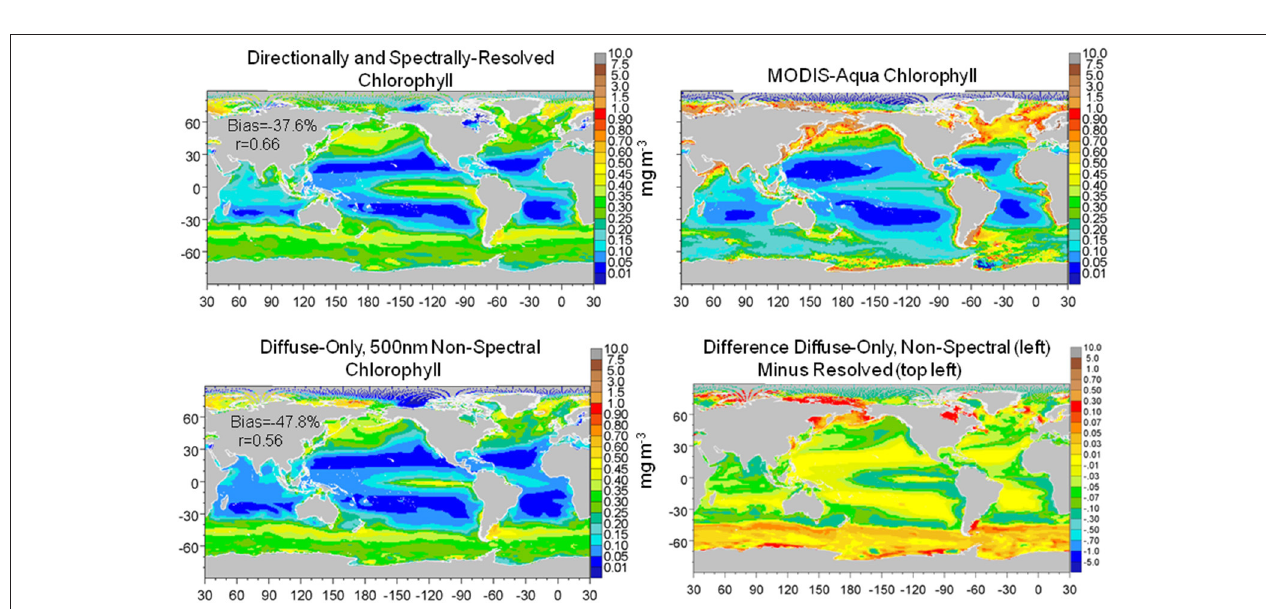
FIGURE 10 | Global distribution of chlorophyll from the directionally and spectrally-resolved model, climatological satellite data, the diffuse-only, 500 nm non-spectral simulation and the ditierence. Statistics on global distributions compared to satellite data are shown in the plots. The directionally-spectrally resolved correlation is statistically significant at P < 0.05; the ditiuse-only + non-spectral model is not.